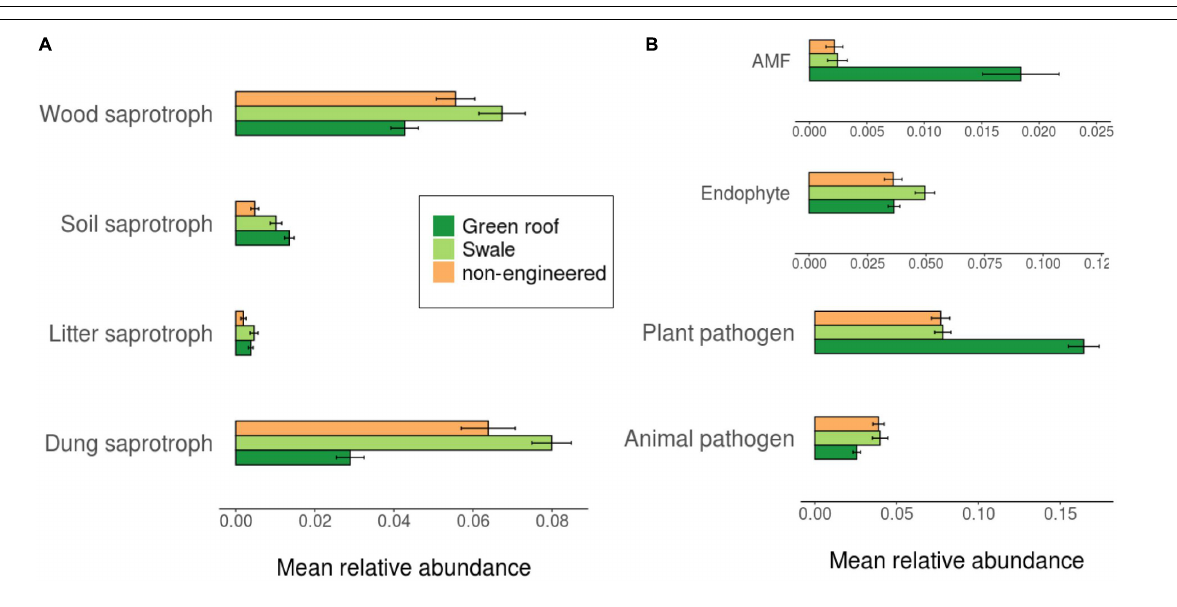
FIGURE 7 | Mean pairwise distances (MPD) for total bacterial communities (A) , and variants related to sets of nitrogen cycling (B) , decomposition (C) , and biodegradation (D) traits. Asterisks on mean bars denote significance values for t -tests comparing means to zero, which signifies the null expectation for local phylogenetic diversity given the species pool (mean MPD significantly below zero signifies phylogenetic clustering). Asterisks between groups indicate significance of t -tests for pairwise differences of group mean MPD values.